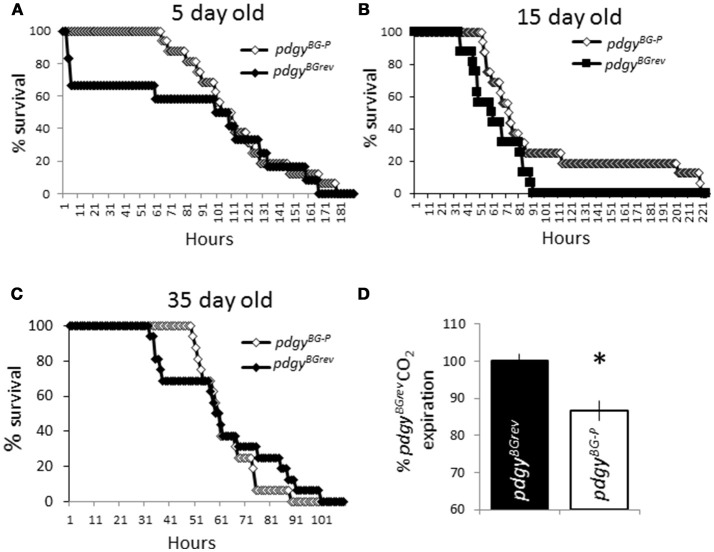
Pdgy mutants are not generally unfit flies. pdgyBG−P and pdgyBGrev were put on peroxide in their food different ages, 5 d.o. (A), 15 d.o. (B), and 35 d.o. (C). n = 16 for each condition. (D) We measured levels of CO2 expired as an indicator of respiration. Levels of CO2 are displayed as percent of control. *p < 0.05.